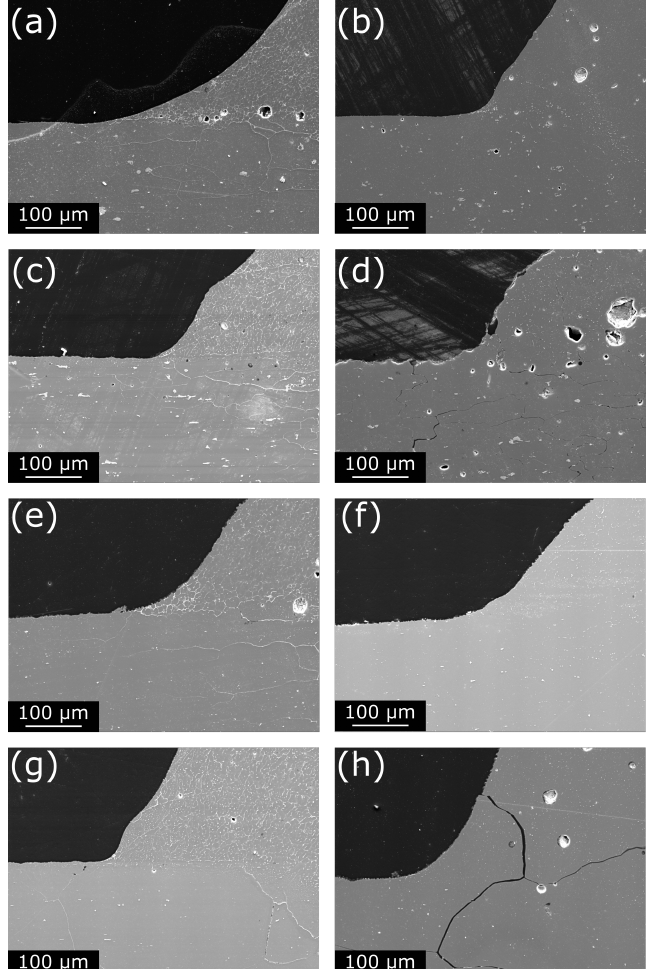
Figure 8. SEM images of ISDM before (left column) and after (right column) heat treatment for the four configurations with the ( a , b ) 2219, ( c , d ) 2024, ( e , f ) 2050 and ( g , h ) 2139